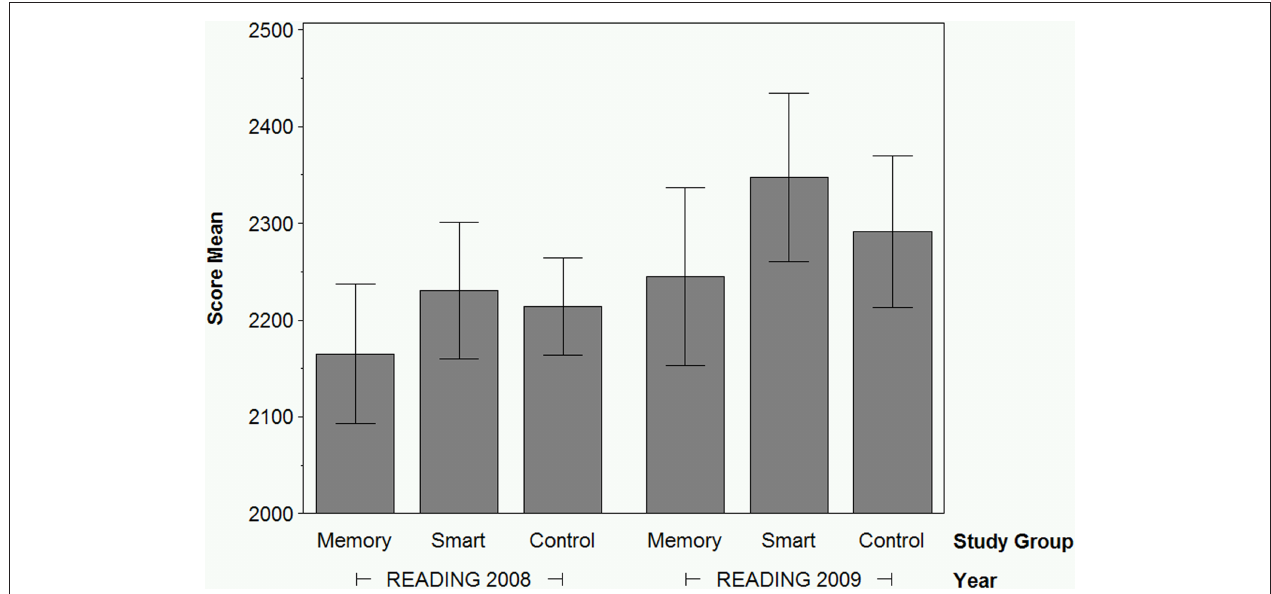
FiGuRe 3 | A positive trend for the SMART group of higher scaled scores on TAKS reading test.